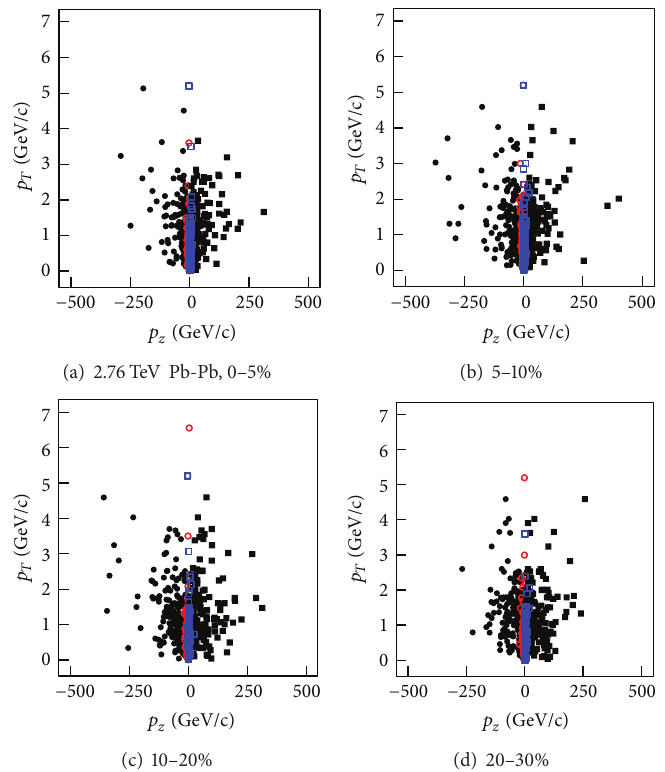
Figure 7: The same as for Figure 4, but showing the results in the space 𝑝 𝑇 − 𝑝 𝑧 .